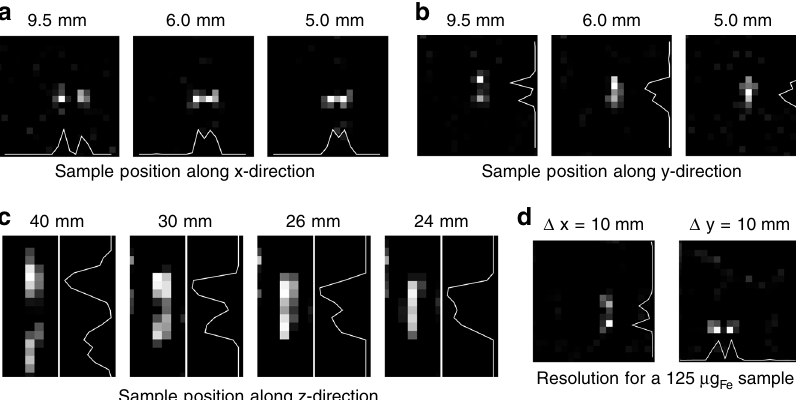
Fig. 3 Spatial resolution of the developed MPI brain scanner. a – c Two samples of 250 μ l Perimag with a concentration of 8.5 mg Fe ml − 1 were placed at varying distance along the x − direction, y − direction, and z -direction. The pixel spacing of the images is 5 mm and marks the lower boundary that can be reached. In x -direction the samples can be separated even for a distance of 5 mm. In y -direction the samples with 5 mm distance cannot be resolved such that the resolution limit in y -direction is 6 mm. In z -direction the samples can be resolved down to a distance of 26 mm. d For an iron mass of 125 μ g Fe the resolution in x -direction and y -direction remains below 10 mm